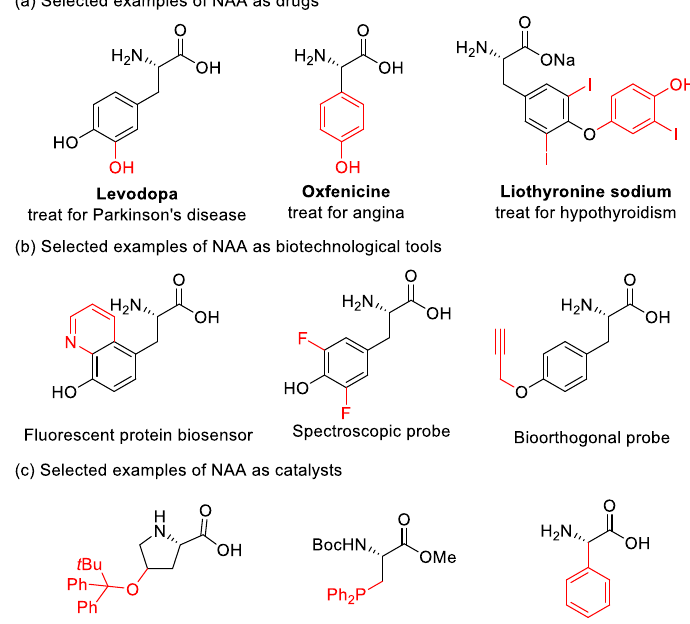
Figure 1. Selected examples of non-proteinogenic amino acids (NPAAs) as drugs ( a ), biotechnological tools ( b ) and catalysts ( c ).